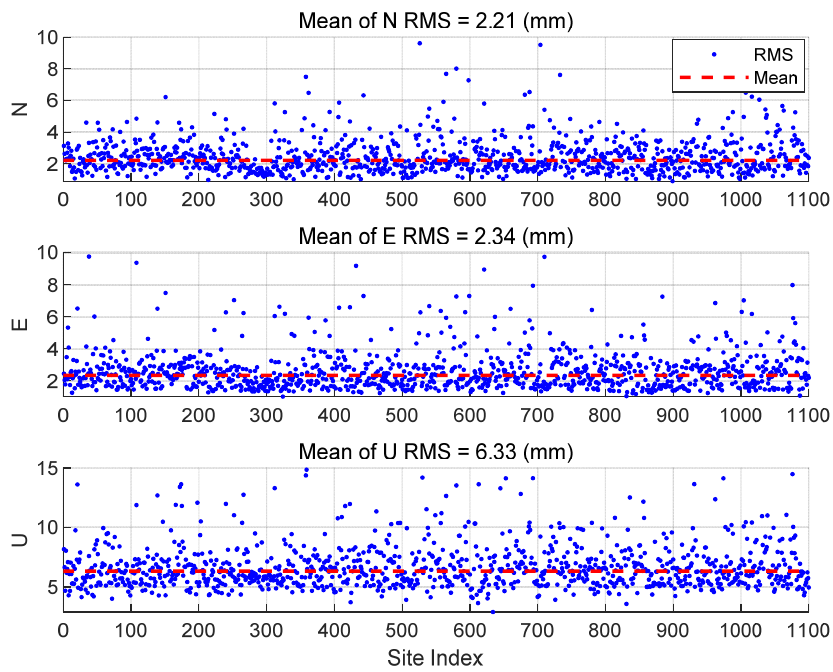
Figure 15. The fitting RMSE of all GNSS time series using ITSM.